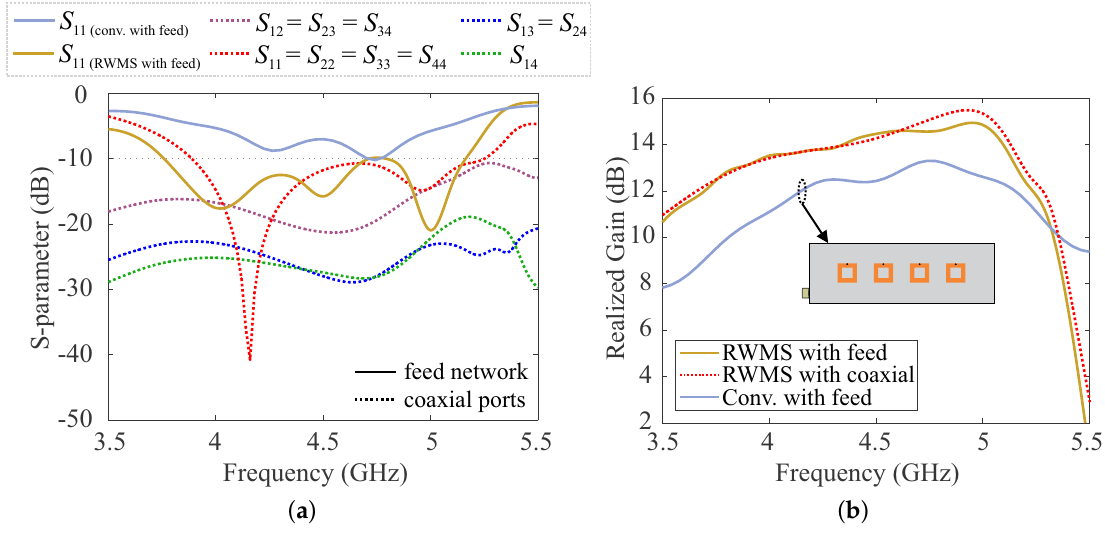
Figure 2. ( a ) S-parameters and ( b ) the broadside realized gain of the 1 × 4 RWMS